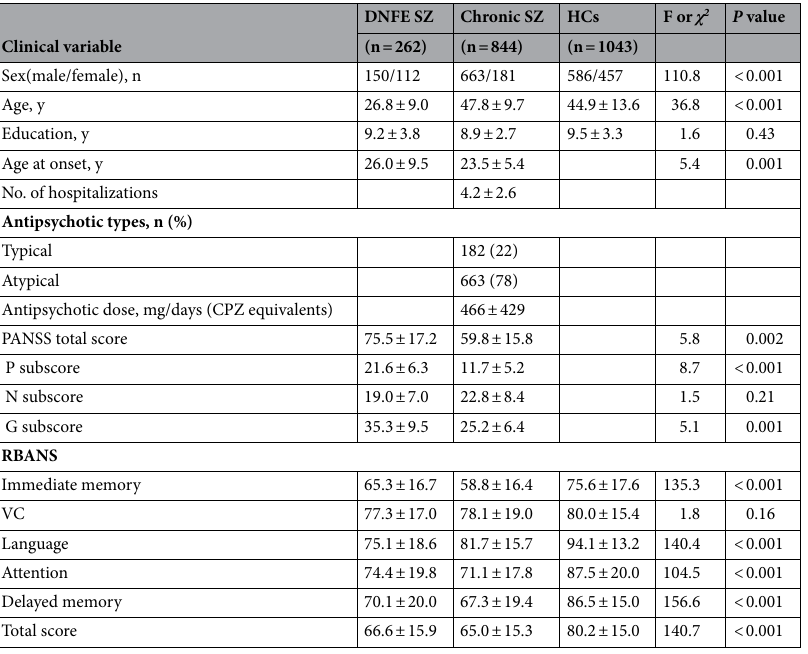
Table 1. Demographic, clinical data and neurocognitive function in SZ patients and HCs. Abbreviations: DNFE drug-naïve and first episode, SZ schizophrenia, HC healthy controls, CPZ chlorpromazine, P